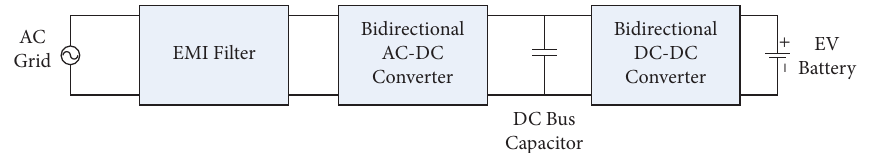
Figure 1: Schematic illustration of a standard EV onboard battery charger